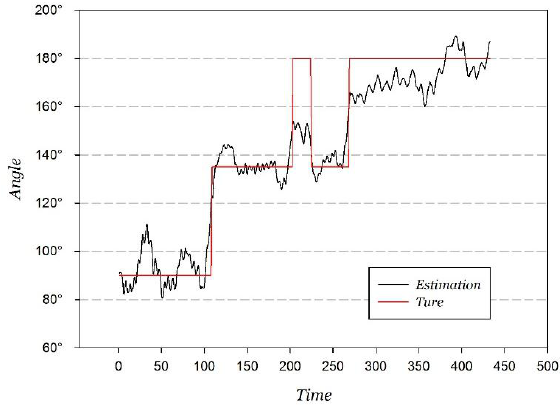
Figure 15. Orientation estimation and true value.